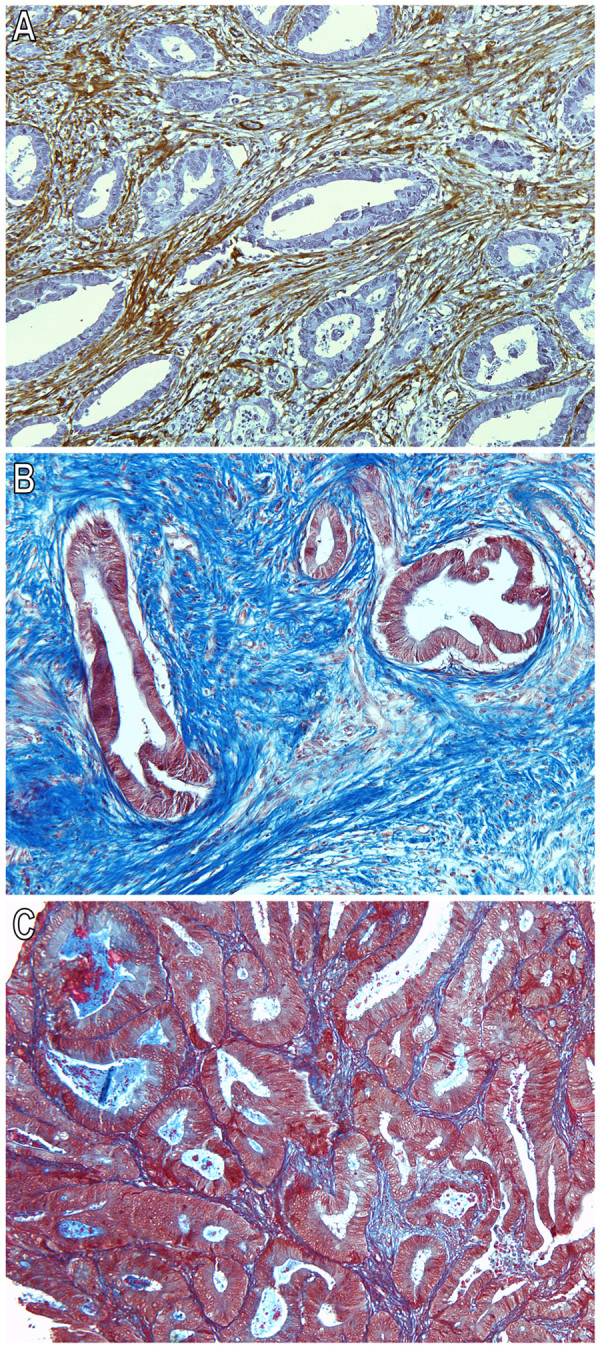
A: Immunohistochemistry (IHC) of alpha-Smooth muscle actin (α-SMA, prediluted mouse monoclonal anti-α SMA, Abcam, Cambridge, UK) in a Stage IIIC colorectal carcinoma with high PRL-3 mRNA expression [8]. Representative slide photography showing intense staining of stromal cells corresponding to CAFs. Briefly, mouse monoclonal anti-α SMA antibody was diluted 1/3 in PBS and incubated for 1 hour at room temperature. After washing steps, reaction was visualized using EnVision anti-mouse antibody system, and developed using DAB-Plus Kit (Dako, Copenhagen, Denmark). Slides were counterstained with Harry's modified hematoxylin. As a negative control, we used EnVision anti-mouse antibody system which displayed no reactivity against any antigen. Positive and negative controls were included in each assay. For IHC quantification, we evaluated non-adjacent tumoral regions to the muscular layer to avoid confusing results. Expression was evaluated according to intensity (1 = -, undetectable or + light; 2 = ++, moderate; 3 = +++, intense staining) and percentage of stain (1 = < 10%; 2 = 10–50%; 3 = > 50%). A score containing the information for both parameters [(intensity +1) × percentage] was assigned, classifying staining as "low" or "high". B: Intense deposition of collagen fibrils in a high mRNA PRL-3 expression Stage IIIC colorectal carcinoma, using Masson trichrome staining (Sigma-Aldrich). To evaluate staining we considered the percentage of tissue occupied by collagen fibrils in relation to total tissue area in each slide without taking into account the muscular layer (< 5% absence; 5–15% slight; 15–50% moderate and > 50% intense deposition). C: Slight deposition of collagen fibrils in a Stage IIIC colorectal carcinoma with previously documented low levels of mRNA PRL-3 expression [8].